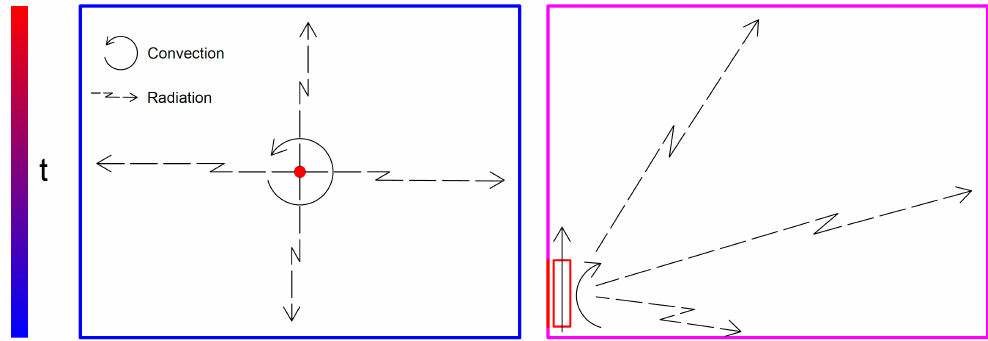
Figure 1. Ideal point heater ( left ) and real heat emitter ( right